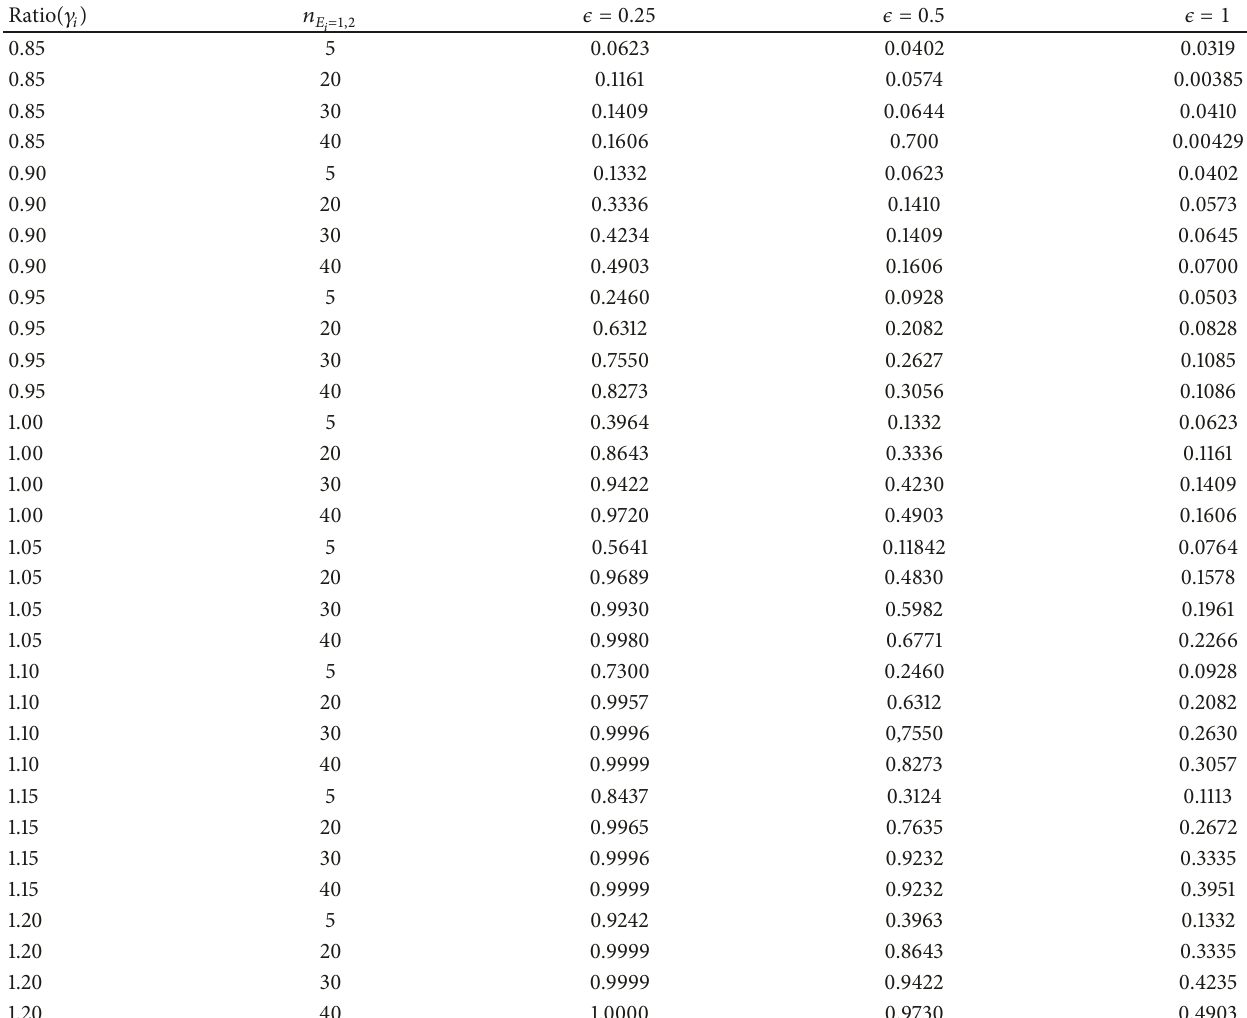
Table 2: Power Estimation of the confidence intervals for 𝜎 𝑅 = 10,𝜎 𝑃 = 10,𝜎 𝐸